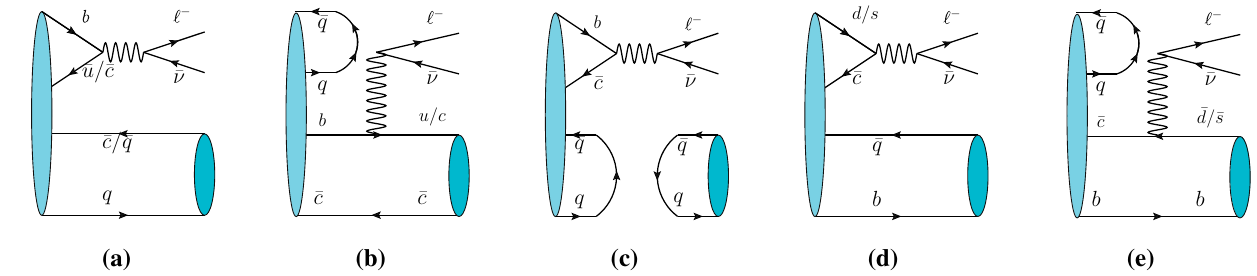
Fig. 1 Topological diagrams for semileptonic decays of tetraquark T b ¯ c 8 / T b ¯ c 1 . a – c Correspond to the b quark decay and d , e denotes the ¯ c quark decay. It is necessary to point out that any gluon exchange can